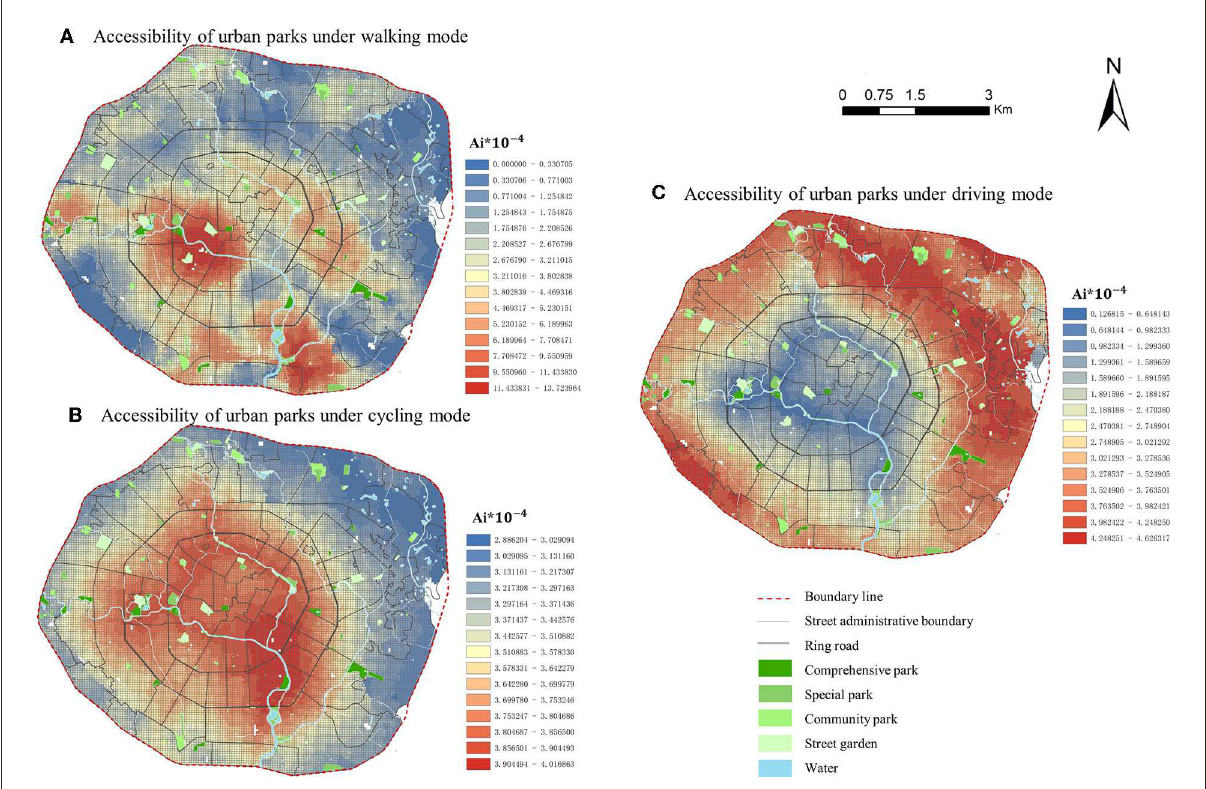
FIGURE8 Spatial distribution of park accessibility under different travel modes in Chengdu,